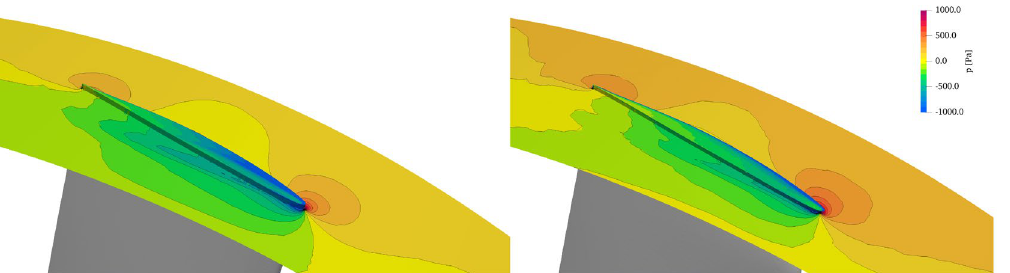
Figure 11. Relative pressure contours on iso-radius surface at 99% of the blade span. Left: datum; right: whaled.